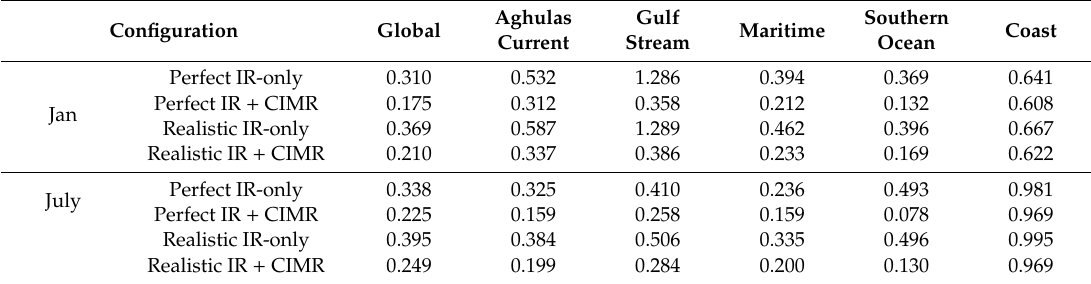
Table 2. Root-mean-square error in di ff erent regions for the various experimental configurations.